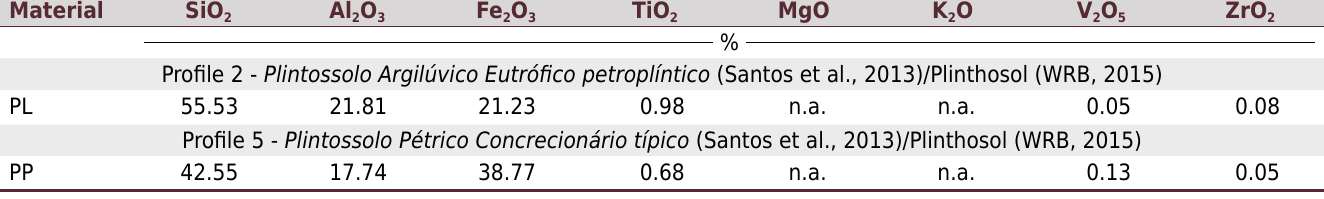
n.a. = not analyzed.